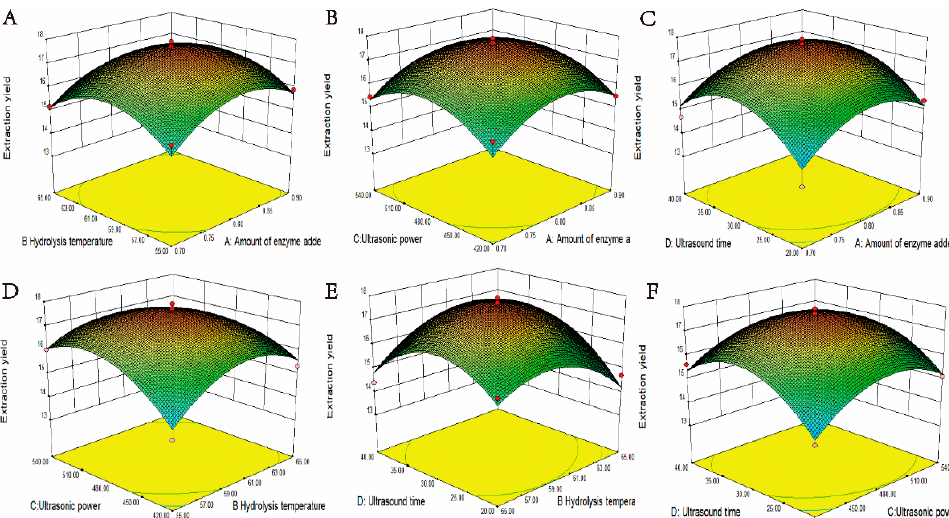
Figure 2. Response surface diagram of the interaction between the factors. ( A ) Effect of hydrolysis